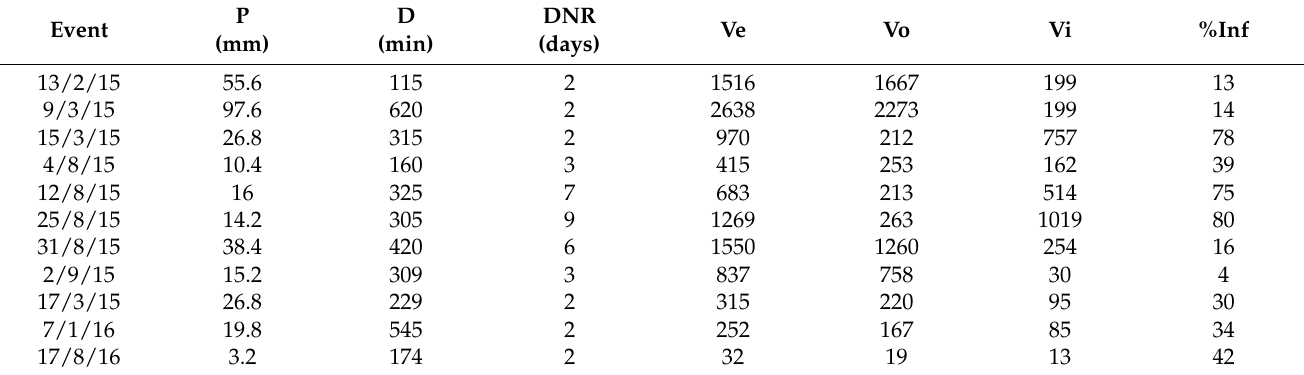
Table 3. Swale performance in controlling runoff for some selected